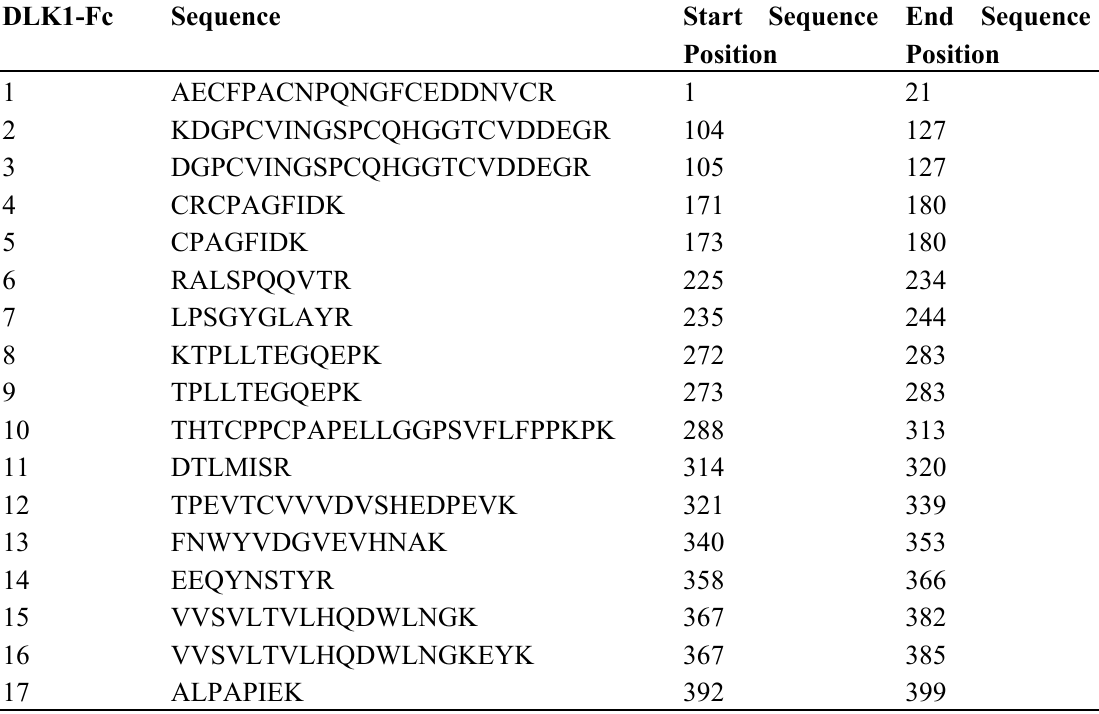
Figure 1. Recombinant fragment of human delta-like 1 homolog protein (DLK1) was expressed and characterized. ( A ) Schematic representation of DLK1 protein structure which comprises 6 epidermal growth factor (EGF)-like extracellular domains, a juxtamembrane region (JM), a transmembrane domain (TM) and a short intracellular region (IC). ( B ) Schematic representation of a DLK1-Fc fragment. Extracellular part of DLK comprising six EGF-like domain and a juxtamembrane region was fused to the CH2 and CH3 domains of the Fc part of IgG1. The fusion protein forms a covalent dimer. ( C) SDS-PAGE profile of recombinant human DLK1-Fc fusion protein. M-marker; NR-DLK1-Fc under non-reducing conditions; R-DLK1-Fc under reducing conditions. ( D ) Size exclusion chromatography of the expressed DLK1-Fc fragment on Superdex S200 column. Table 1. List of peptides obtained by tryptic digestion of the DLK1-Fc fusion